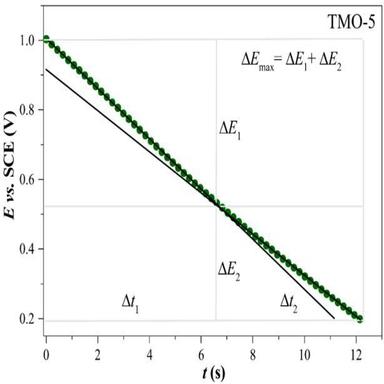
General profile of the discharging curves verified for TMOs. Electrode: TMO-5. It is shown the geometric interpretation of the linear segments according to the GE model. For details involving the regression statistics, see Fig. S2. Rl and Rn values (R = δE/Igcd) were determined from the drop potential (δE) verified at t = 0 from the linear extrapolations involving the two different linear segments corresponding to short (Δt1) and long (Δt2) polarization intervals.